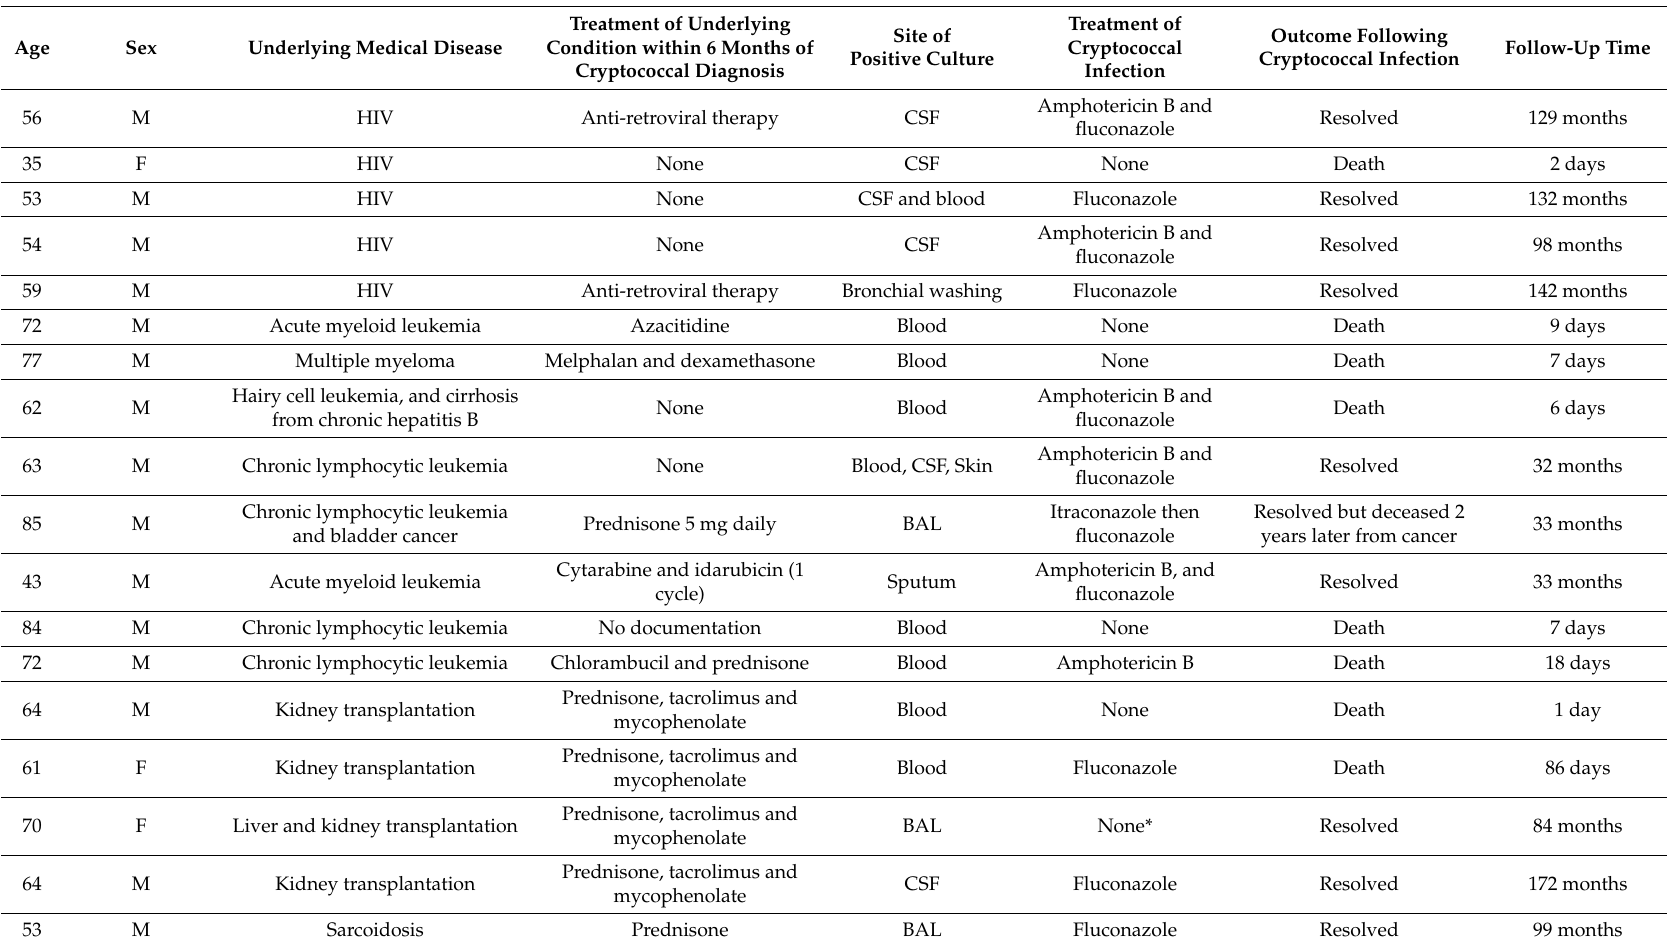
Table 1. Patient characteristics and